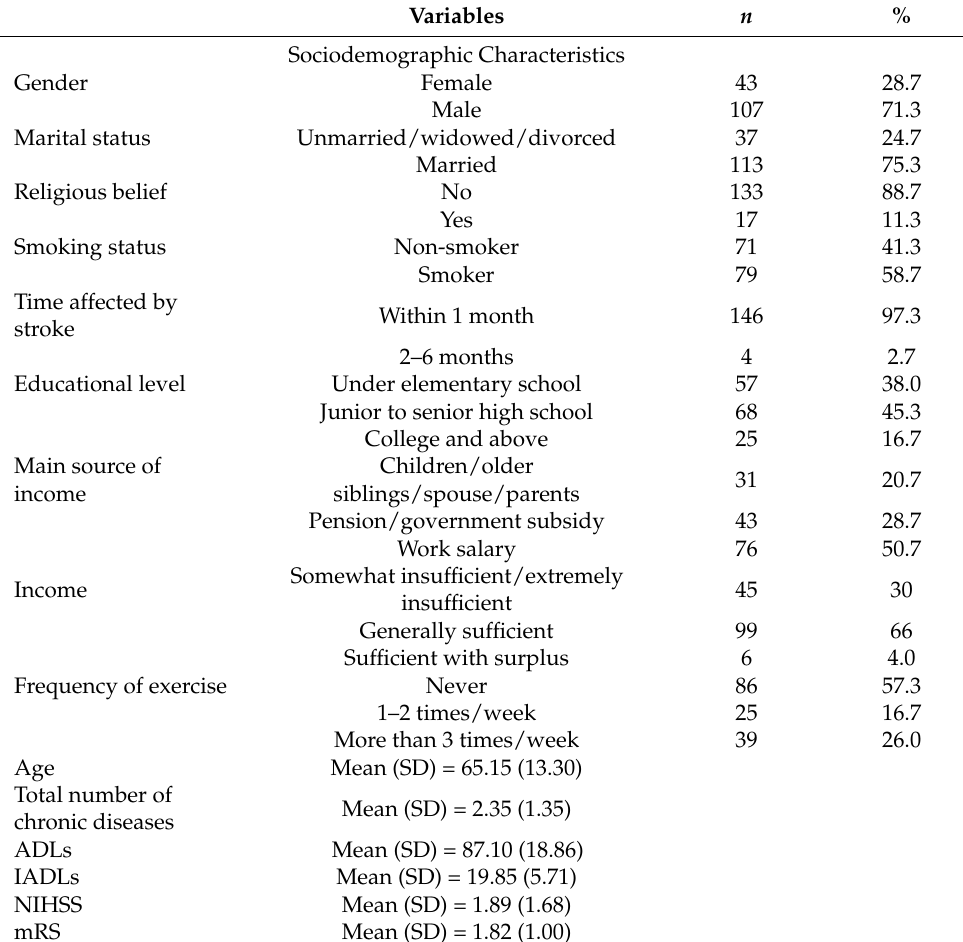
Table 1. The basic demographic data and health status of the participants ( N =